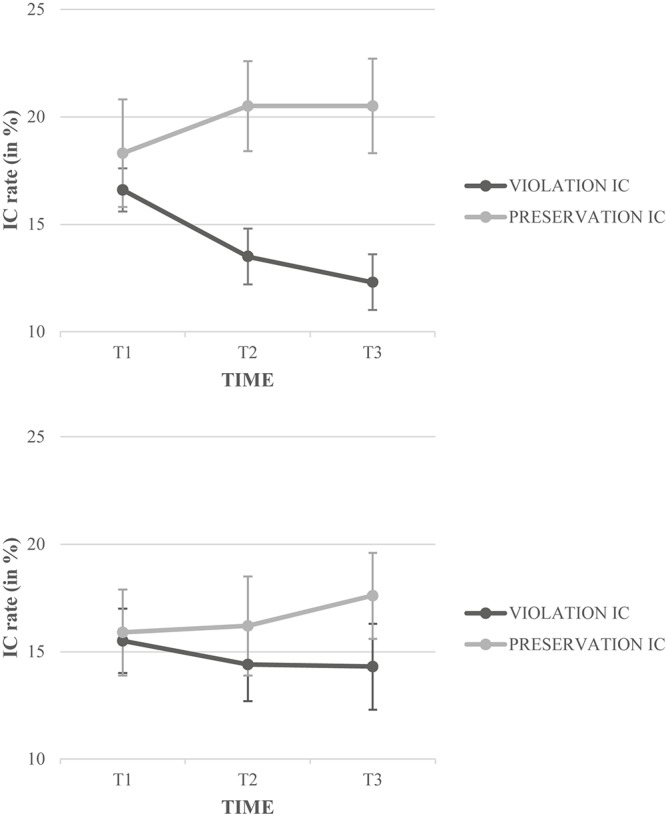
Illusory conjunction rate (IC) in percentage (%) for the Condition × Time × Group interaction as a function of the Group (upper panel, good readers; lower panel, poor readers).